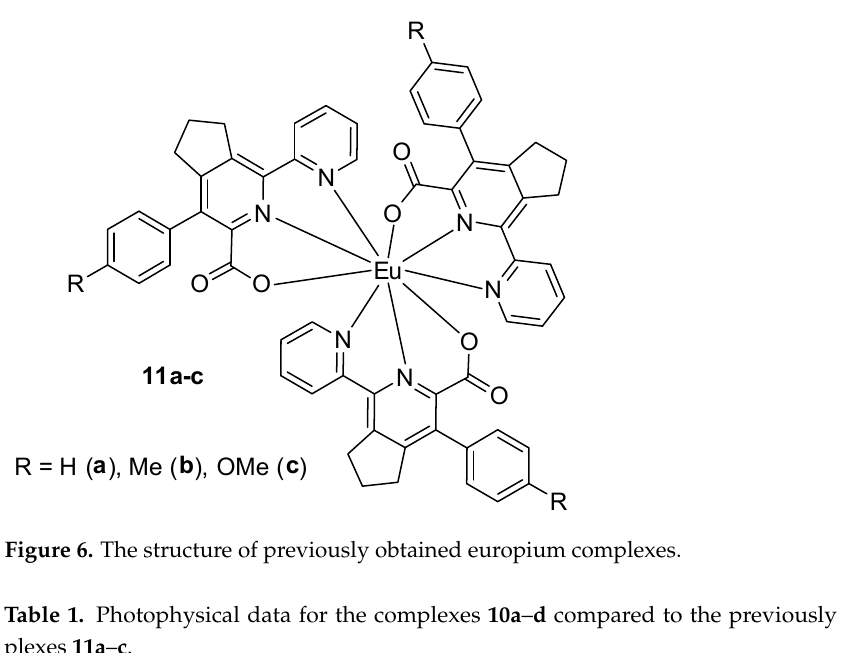
Figure 5. The luminescence spectrum of the Eu(III) complex 10a in DCM at room temperature was obtained by delaying the gate at 305 nm excitation (ligand absorption maximum).